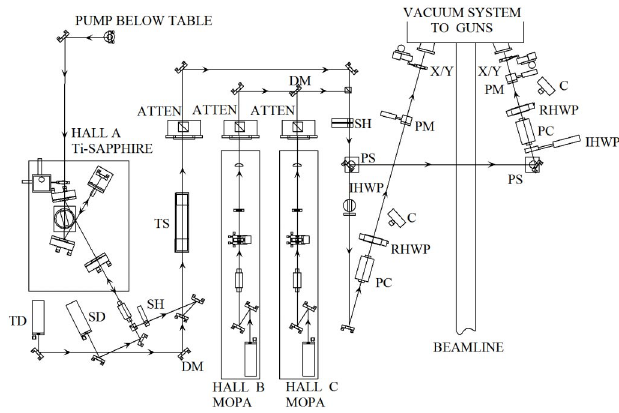
FIG. 10. A typical laser system configuration. The harmonic- mode-locked Ti-sapphire laser provides high current, high- polarization beam to one experimental hall. MOPA lasers pro- vide low current, high polarization, and high current unpolarized beams to the other two halls. Numerous optical components, many remotely controlled, are required for routine operation and are described in the text: T, tune-mode diode laser; SD, gain- switched diode seed laser; SH, shutter; DM, dichroic mirror; TS, telescope; IHWP, insertable half-wave plate; PC, Pockels cell; C, camera; ATTEN, laser attenuator; PM, power meter; RHWP, rotating half-wave plate; X/Y, focusing lens mounted to trans- lation stages; PS, periscope